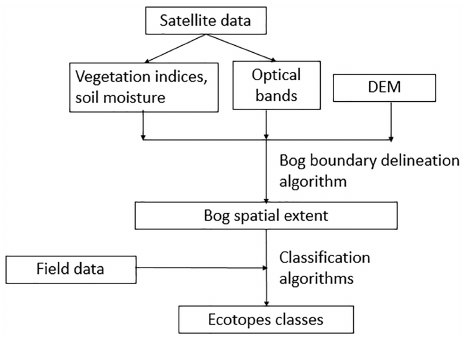
Figure 3. Methodology